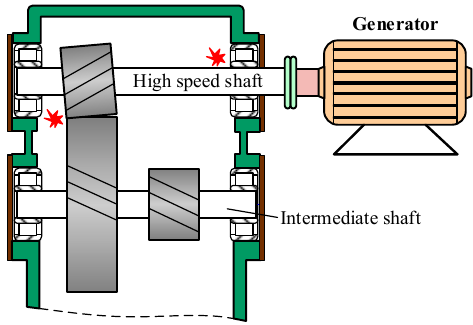
Figure 26. Failure mechanism of compound faults in a wind turbine gearbox.